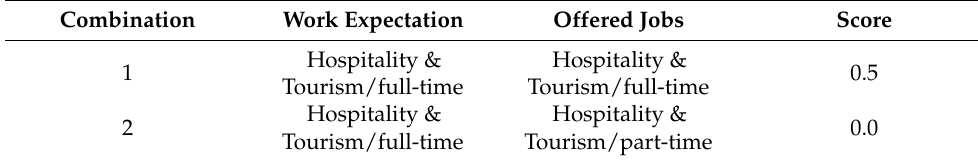
Figure 13. CQ_06: Which job posts match the migrant’s expectations for finding work? Table 8. Expectations’